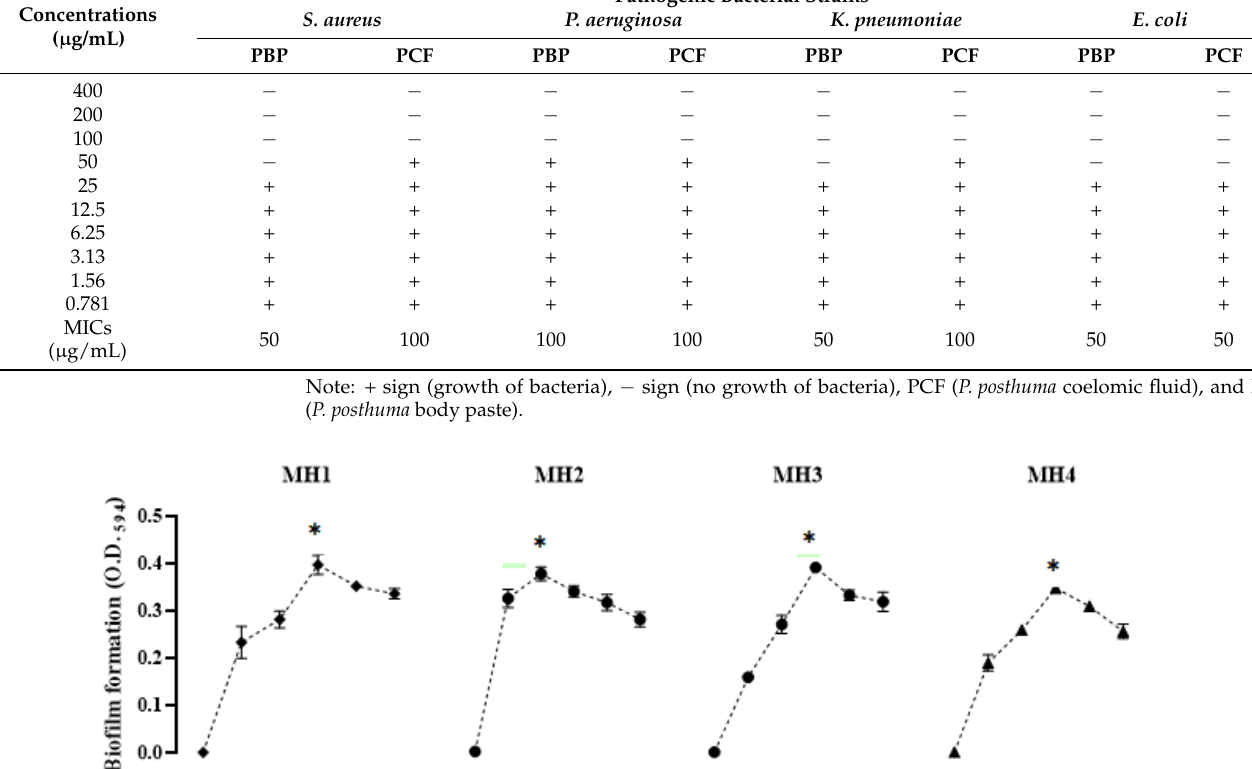
Table 2. Minimum inhibitory concentration of PBP and PCF against four pathogenic bacteria. Pathogenic Bacterial Strains S. aureus